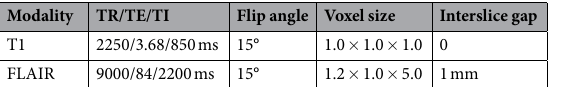
Table 1. MR imaging protocol specification for the T1 and FLAIR